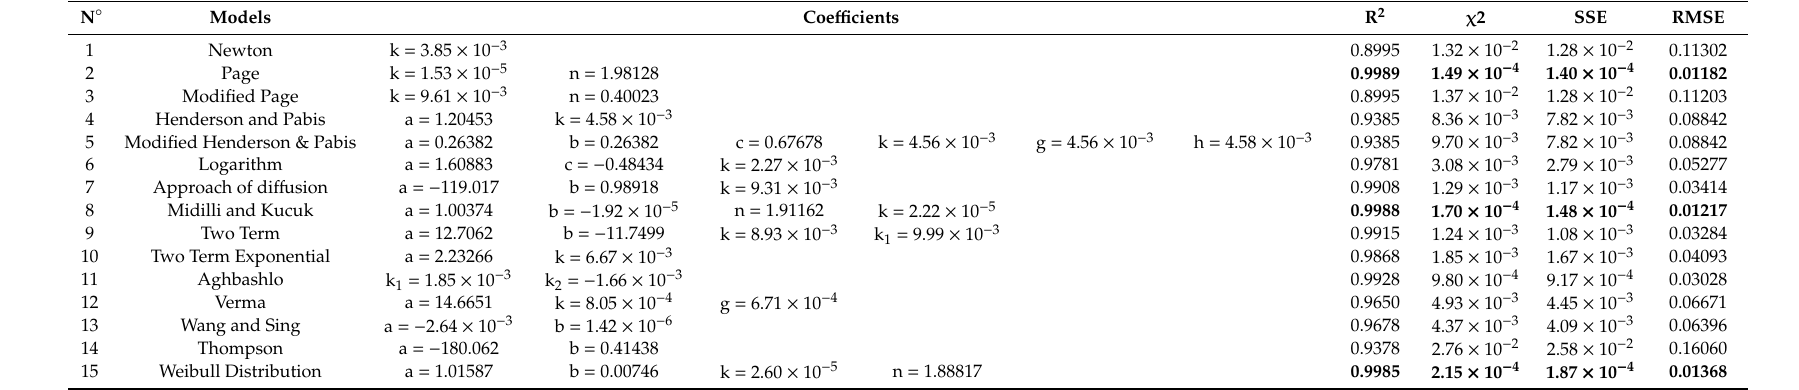
Table 2. Statistical results from modeling the moisture content and drying time for shredded lettuce